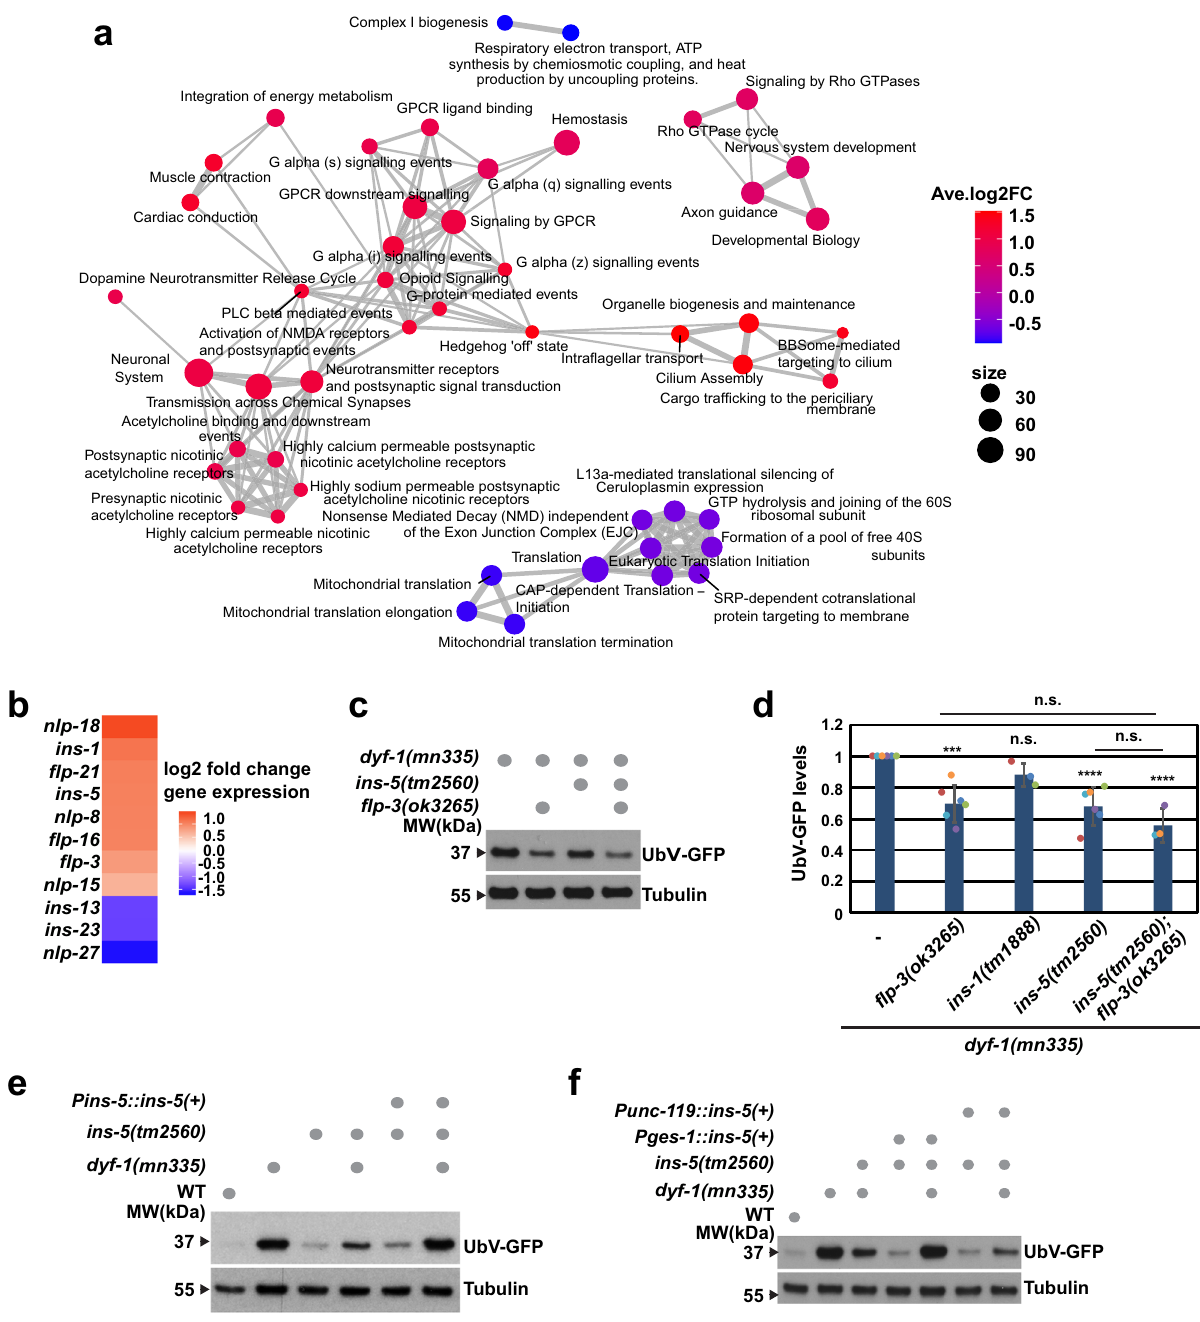
Fig. 4 | FLP-3 and INS-5 signalling peptides control UPS-dependent protein turnover. a Pathways (Reactome) signi fi cantly ( q -value < 0.01) affected in dyf- 1(mn335) compared with WT identi fi ed by GSEA (Methods), based on microarray data.Eachpathwayisrepresentedbyabubble,sizeofabubble:sizeofthepathway (number of its gene members affected). Thickness of edges re fl ects proportion of genes shared between 2 pathways. Colour of nodes re fl ects average change of the pathway gene members, red: the genes are upregulated, blue: genes are down- regulated. b Heatmap of differentially expressed neuropeptides ( q -value < 0.01) in dyf-1(mn335) comparedwithWTbasedonmicroarrayanalysis.Colourofcells:log2 fold change of gene expression in dyf-1(mn335) compared with WT, n =4 biologi- cally independent experiments. c Worms expressing the UFD substrate and the mutations indicated were grown and analysed as in (Fig. 2b). d Quanti fi cation of UbV-GFP levels of worms from ( c ) and additionally dyf-1(mn335); ins-1(tm1888) . 6